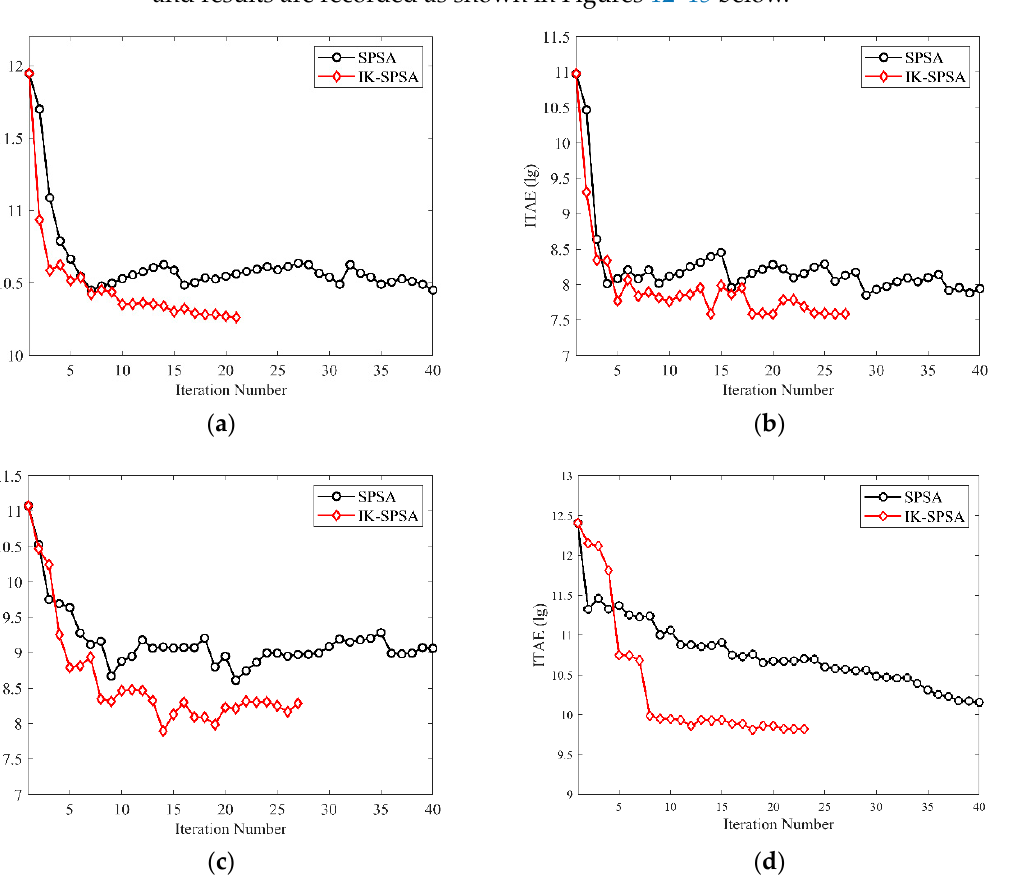
Figure 12. Trajectories of iteration: ( a ) 5% FP; ( b ) 30% FP; ( c ) 50% FP; ( d ) 100% FP.